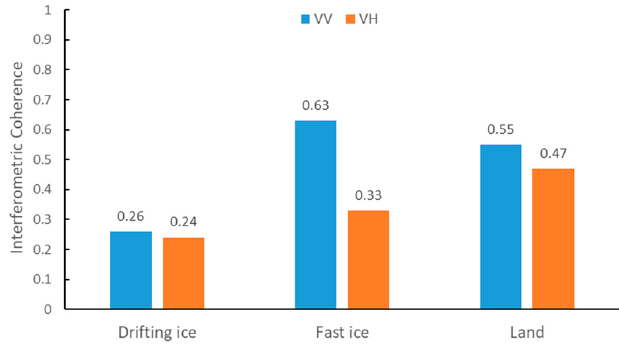
Figure 6. Coherence statistics under different polarizations.